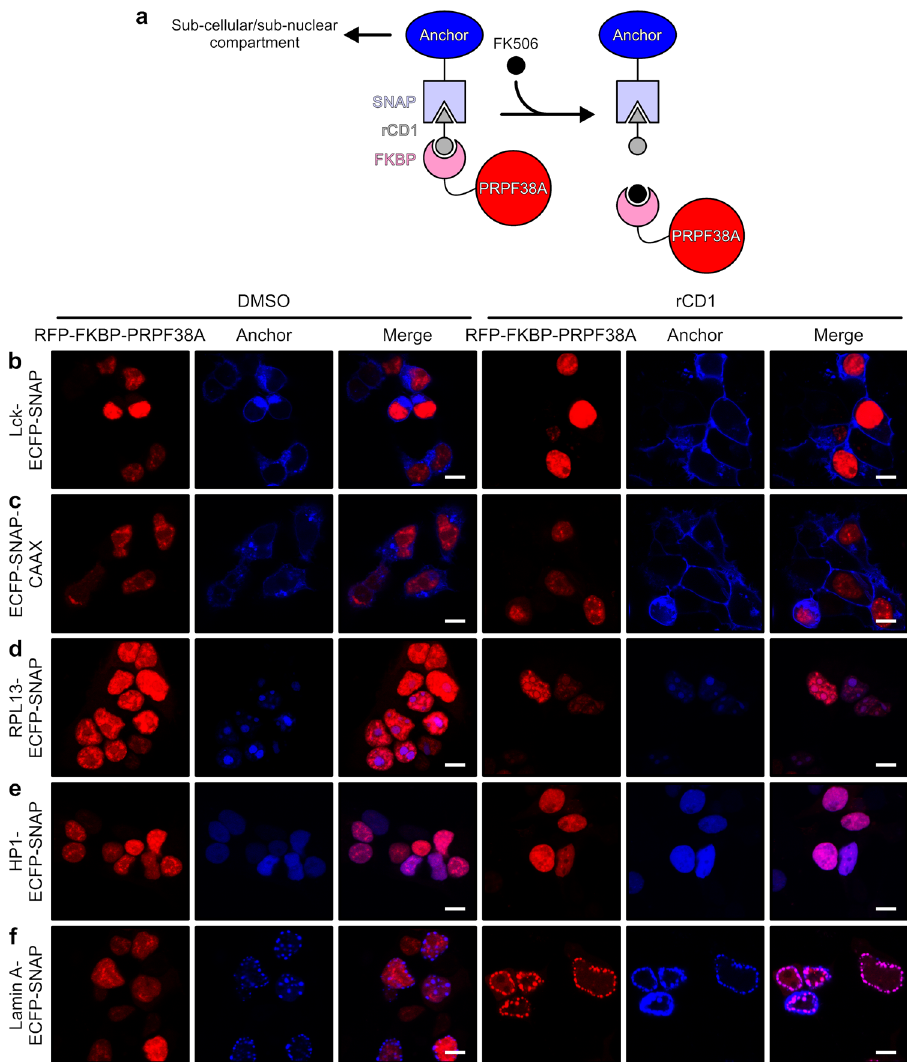
Fig. 1 Test of anchor proteins. a Dimerization principle of rCD1. The compound rCD1 induces dimerization of a SNAP-tag and an FKBP tag. The FKBP- tagged target protein is recruited to the SNAP-tagged anchor protein. The dimerization is reversed upon the addition of FK506. b – e HEK293T cells were co-transfected with vectors expressing the indicated (on the left) anchor-ECFP-SNAP or ECPF-SNAP-anchor protein fusions (blue channel) and the target- RFP-FKBP-PRPF38A protein fusion (red channel). The localization of the proteins was monitored in DMSO-treated cells (groups of three panels on the left) or after rCD1 treatment (groups of three panels on the right) for 30 min. Each group of three images shows the red channel (RFP-FKBP-PRPF38A; left), the blue channel (anchor-ECFP-SNAP or ECFP-SNAP-anchor; middle), and a merged image (right), as indicated on the top. Scale bars (10 μ m) are shown as white lines on the bottom right of the merged images. The images did not indicate successful recruitment of RFP-FKBP-PRPF38A to b Lck-ECFP-SNAP at the PM, c ECFP-SNAP-CAAX at the endomembrane system and the PM, and e HP1-ECFP-SNAP in heterochromatin regions. In contrast, partial recruitment to d RPL13-ECFP-SNAP in nucleoli and recruitment to f lamin A-ECFP-SNAP at the lamina upon rCD1 addition could be